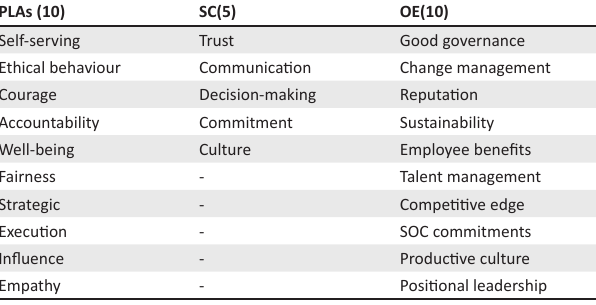
TABLE 4: Survey items that reached consensus by the experts. PLAs